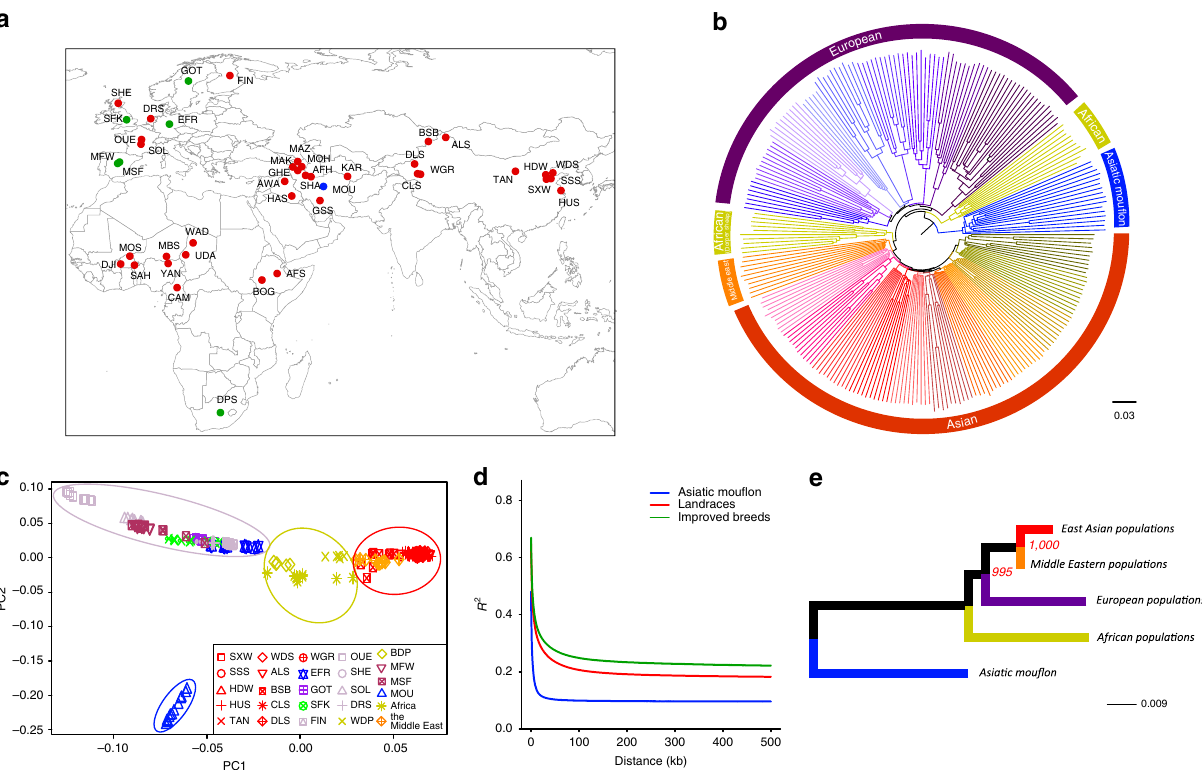
Fig. 1 Geographic distribution and genetic structure of domestic and wild sheep. a The geographic distribution of Asiatic mou fl on, 36 landraces, and six improved breeds, which are represented by blue, red, and green dots on the world map 79 , respectively. MOU, Asiatic mou fl on; AFH, Afshari; AFS, Afar; ALS, Altay; AWA, Awassi; BOG, Bonga; BSB, Bashibai; CAM, Cameroon; CLS, Celle Black; DJI, Djallonké; DLS, Duolang; DPS, Dorper (WDP, white head; BDP, black head); DRS, Drenthe Heathen; EFR, East Friesian Dairy; FIN, Finnsheep; GHE, Ghezel; GOT, Gotland; GSS, Gray-Shiraz; HAS, Hamdani; HDW, Large-tailed Han; HUS, Hu; KAR, Karakul; MAK, Makui; MAZ, Mazekh; MBS, Mbororo; MFW, Chinese Merino ( fi ne wool); MOH, Moghani; MOS, Mossi; MSF, Chinese Merino (super- fi ne wool); OUE, Ouessant; SAH, Sahelian; SFK, Suffolk; SHA, Shal; SHE, Shetland; SOL, Solognote; SSS, Sishui Fur; SXW, Small-tailed Han; TAN, Tan; UDA, Uda; WAD, West African Dwarf; WDS, Wadi; WGR, Waggir; and YAN, Yankasa. b Neighbor-joining (NJ) tree of the 248 individuals constructed using the p -distances between individuals, with Asiatic mou fl on as an outgroup. c Plots of principal components 1 and 2 for the 248 individuals. d Decay of linkage disequilibrium in the Asiatic mou fl on, landraces, and improved breeds. e Neighbor-joining tree of fi ve genetic groups based on the Reynolds genetic distances. Red numbers beside divergence nodes are bootstrap values based on 1,000 replications. A scale bar represents branch length in terms of percent divergences (%). Source data are provided as a Source Data fi